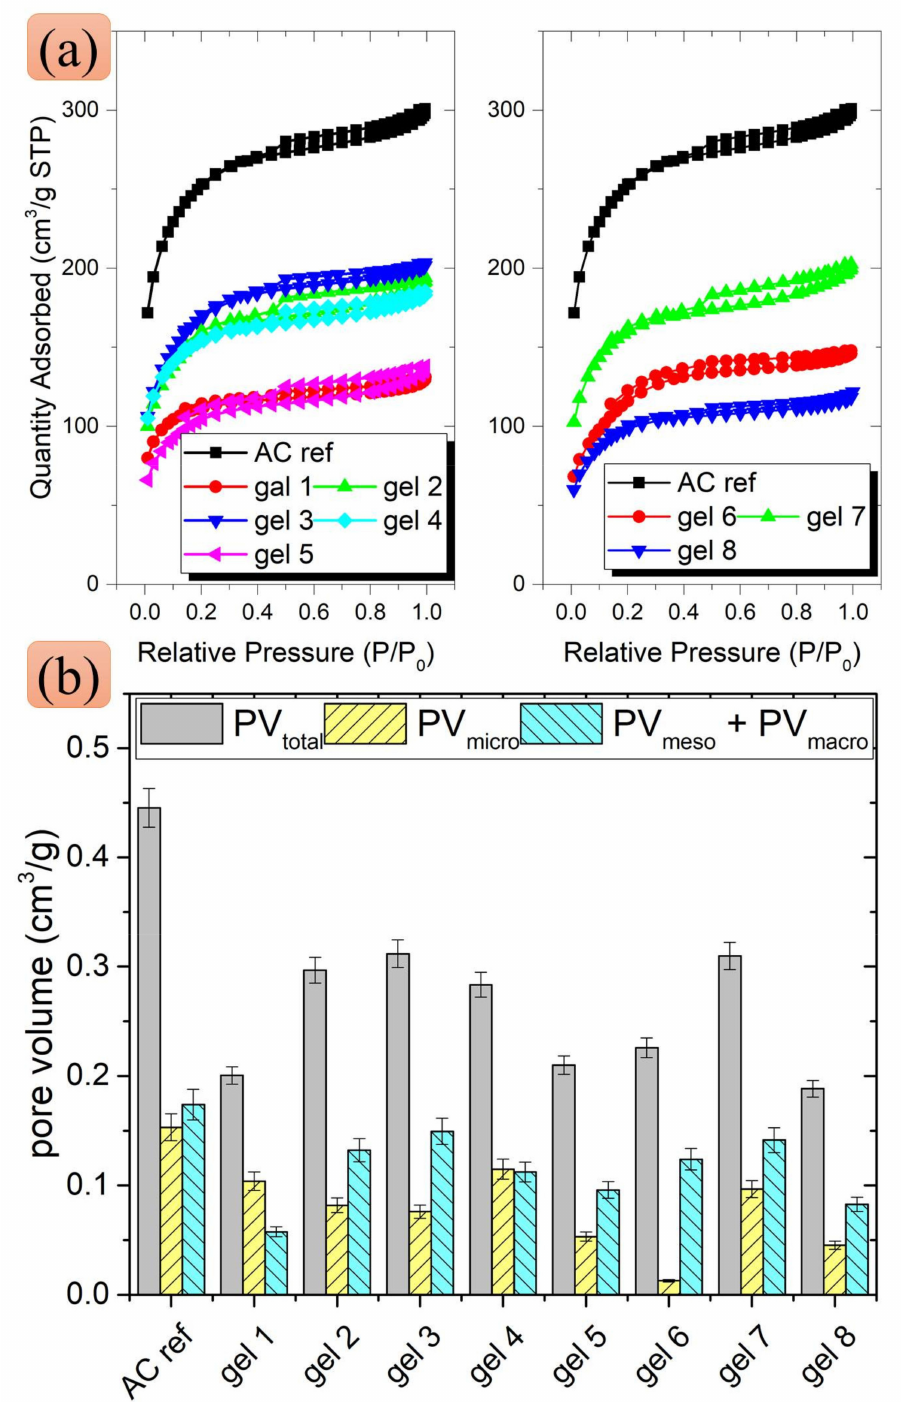
Figure 4. ( a ) N 2 adsorption–desorption isotherms at 77 K and ( b ) total pore volume (PV tot ), PV micro , and PV meso + PV macro of raw and gel-modified RAC. Stack column plots of PV micro and PV meso + PV macro for the raw and gel-modified RAC are presented in Figure 5a. As indicated in Figure 5a, all gel-modified RACs had simultane- ously decreased PV micro and PV meso + PV macro compared with ref AC. While gel 1 was rela- tively PV micro -dominant and gel 6 showed an extremely high amount of PV meso + PV macro , the remaining gel-modified RAC contained a higher portion of PV meso + PV macro . Figure 5b shows the reducing surface area along with the changes in the fraction of PV meso + PV macro